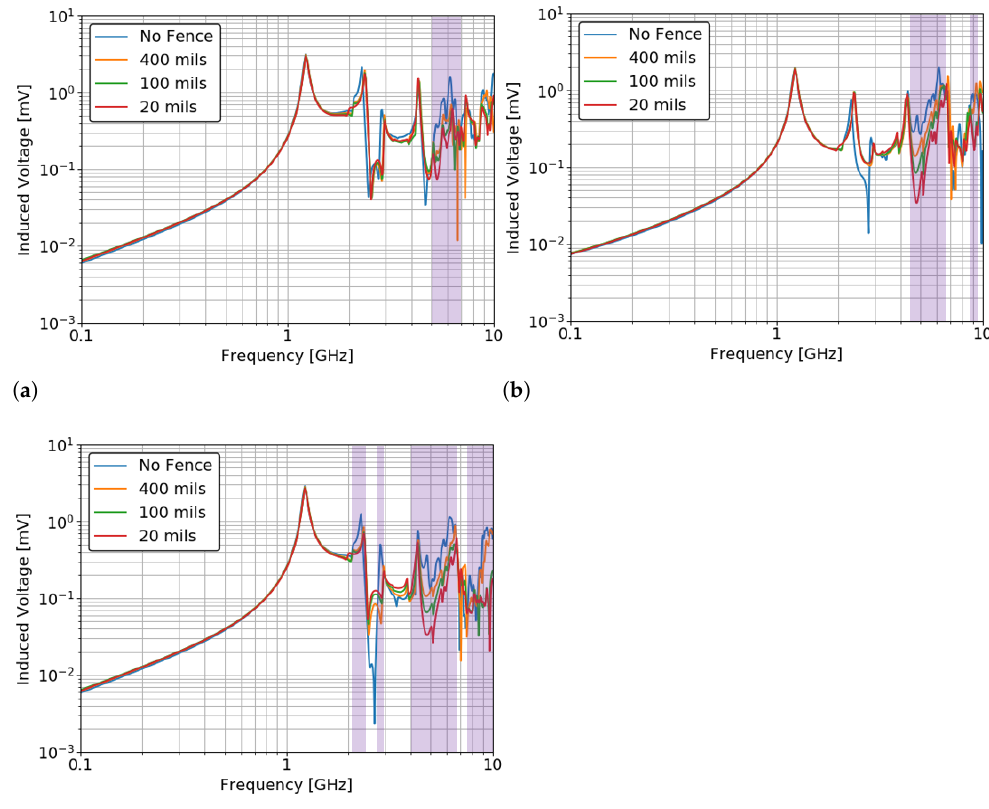
Figure 8. Induced voltage on the power plane of a four-layer practical PCB with varying via fencing density: ( a ) plane wave propagating in the negative z direction (Case 1 ), ( b ) plane wave propagating in the negative y direction (Case 2 ), and ( c ) plane wave propagating in the positive z direction (Case 3 ). The shaded regions indicate where via fencing reduces induced